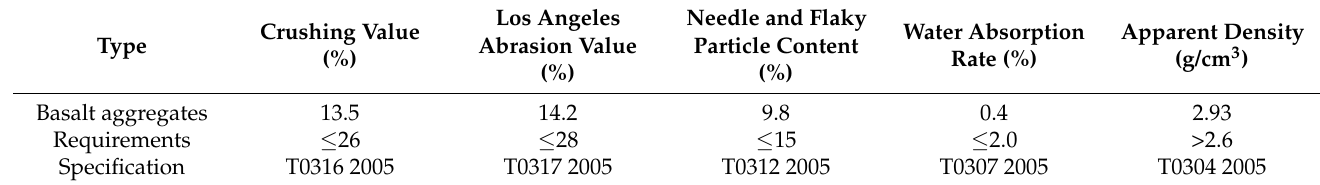
Table 2. Performances of basalt aggregates.